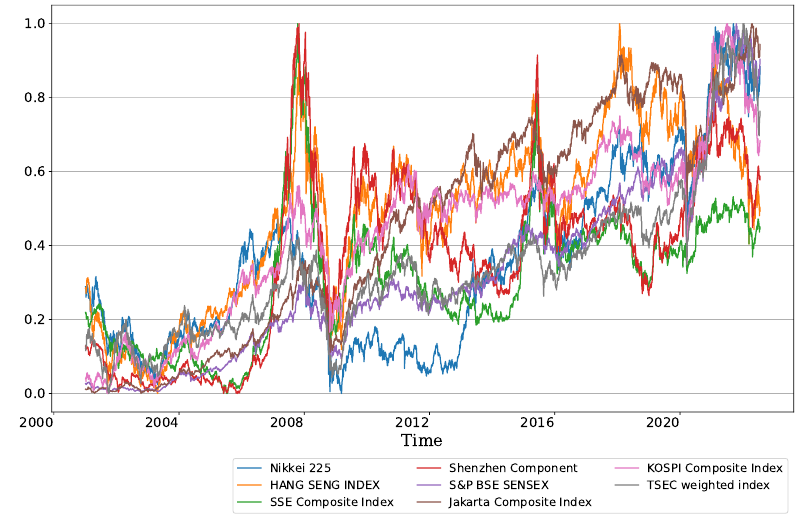
Figure A4. Evolutionary dynamics of Asian financial market indices.